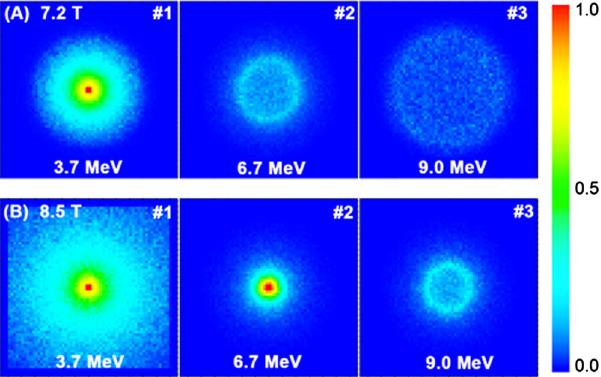
FIG. 8. Simulated film response from proton transport through fields of (A) 7.2 T and (B) 8.5 T for the first three films in each stack. this layer corresponds to 6.7 MeV, and the 6.7 MeV protons in the phase-space plot are highlighted in green. Figure 9 (B) is a projection onto the x axis of the phase-space plot of (A), integrated over (cid:1) , and takes into account the expo- nentially decaying spectrum. The resulting narrow peak shows that most protons are concentrated on or near the axis at the position of the film stack, well in agreement with experimental results. The phase-space plot in Fig. 10 for all laser accelerated protons that exit the solenoid further illustrates the severity of the chromatic aberration. The points highlighted in green represent 13 : 75 (cid:5) 0 : 1 MeV protons that are colli- mated by the 8.5 T field. The curved ends of the phase- space plot are a result of spherical aberration and are directly related to the limb brightening seen in Figs. 6 and 8. The area of an ellipse fit around the phase-space points is by definition the emittance, and if the curved ends of the collimated points were reduced, then the area and emittance are also reduced. Future solenoid designs may generate a more uniform magnetic field by increasing the number of windings at the ends compared to the center, increasing the radii of the middle windings compared to the outer windings, or some combination of both.